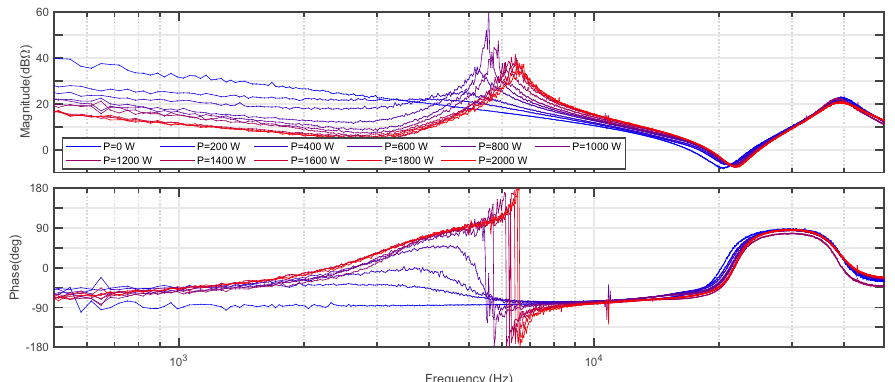
Figure 9. Measured PSU input impedance with input powers varying from 0 to 2000 W (blue to red, from 0% to 80%).